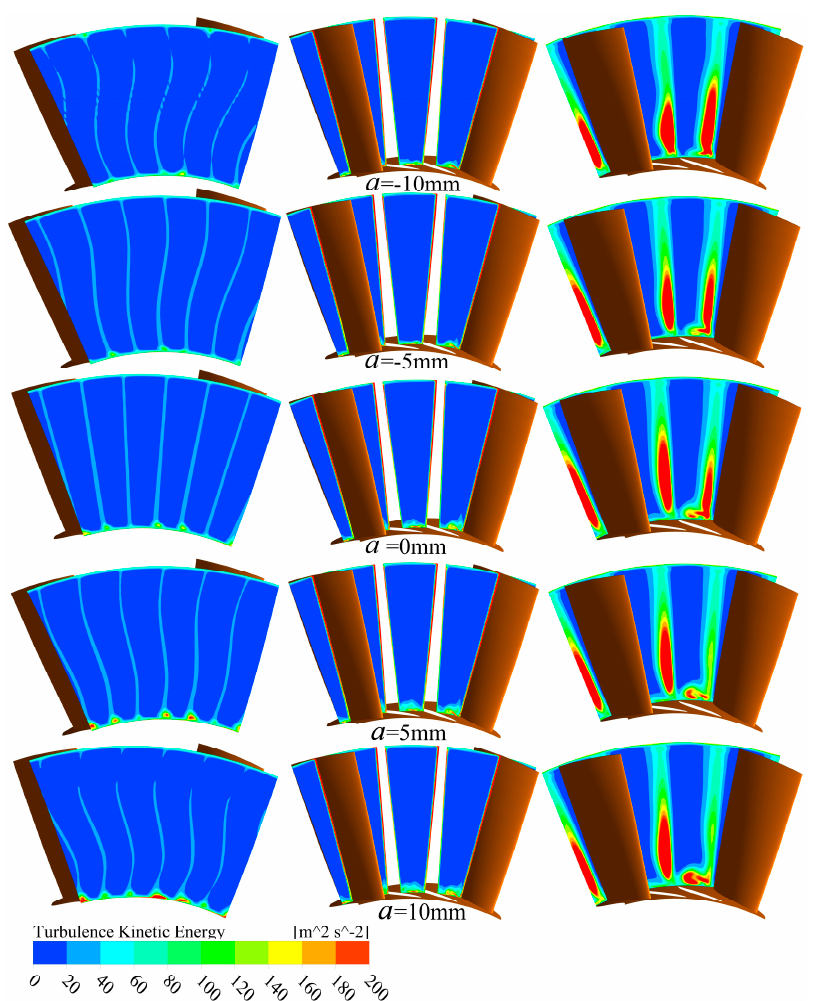
Figure 7. Turbulent kinetic energy distribution of the di ff erent models under design conditions.